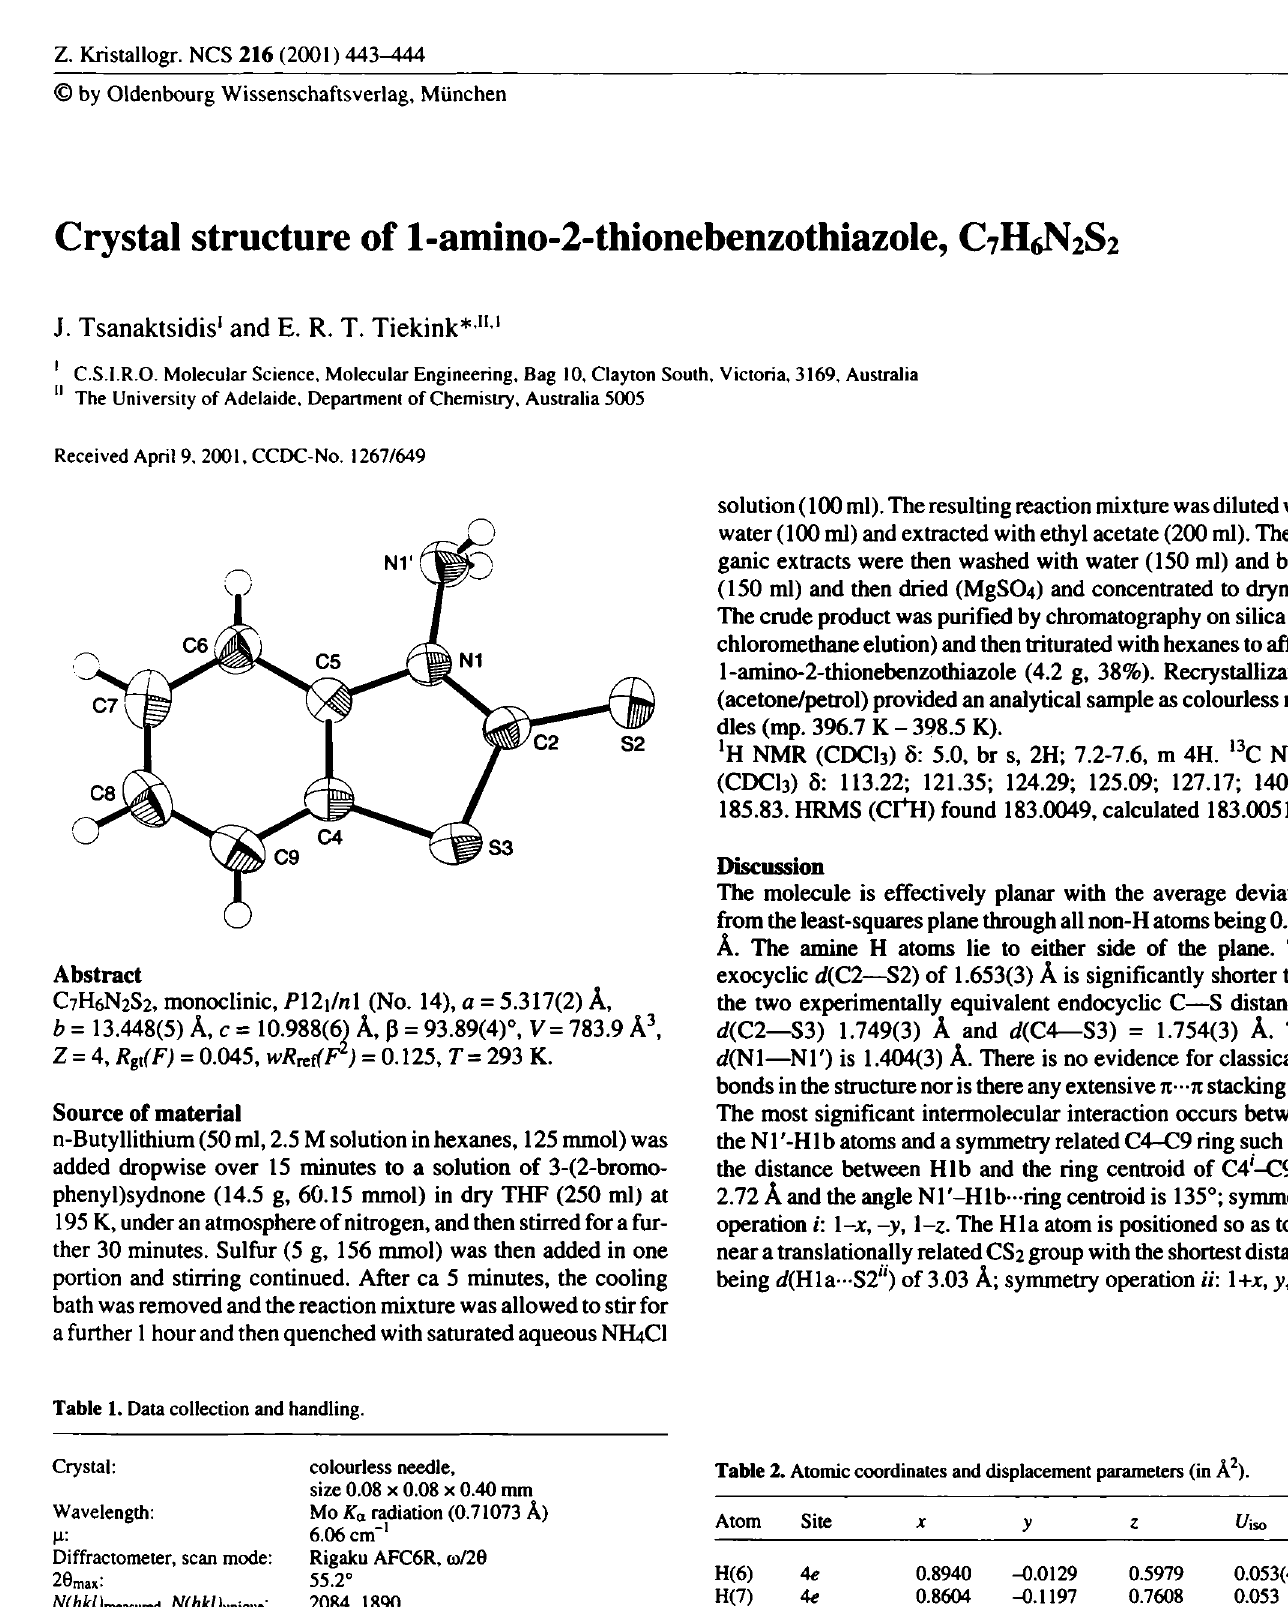
Table 2. Atomic coordinates and displacement parameters (in Ä 2